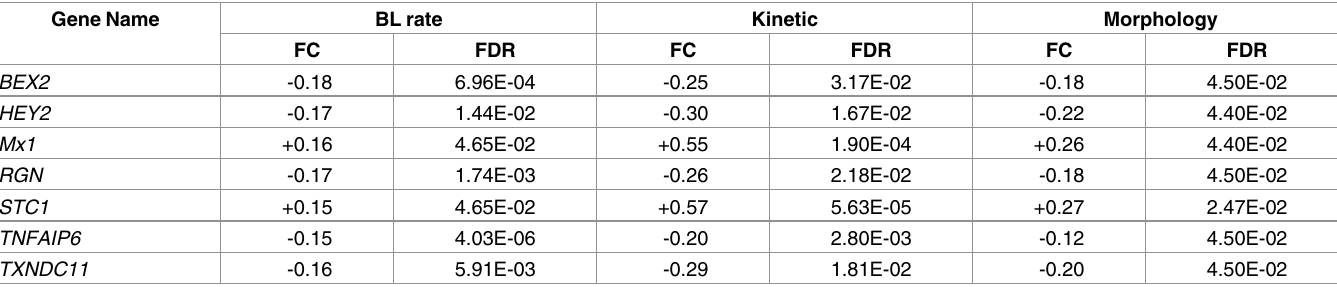
Table 2. Summaryof the Fold Change (FC) and the corresponding FDR for the genes in common among all the IVP scores. Gene Name